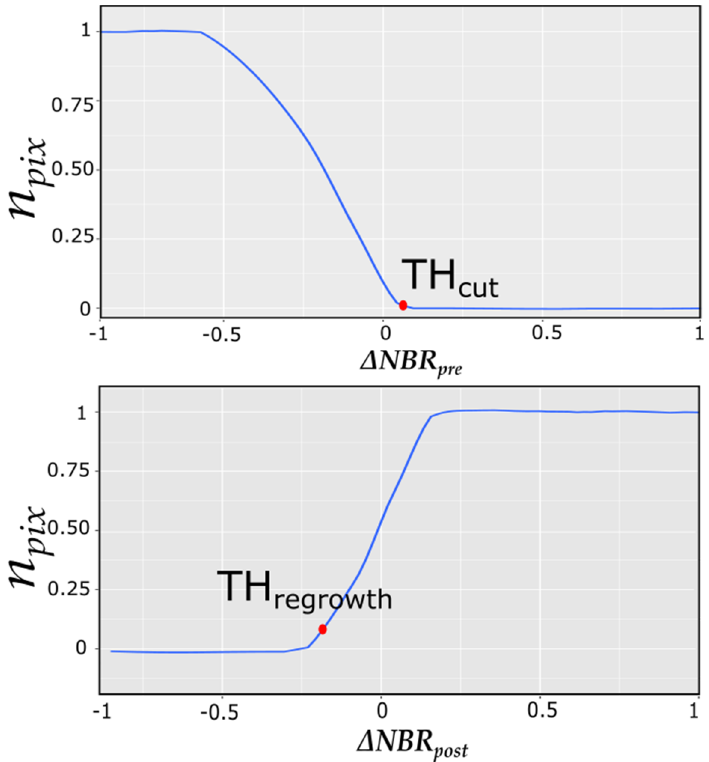
Figure 2. n pix threshold calculated by Two Thresholds Method (TTM) on the basis of cumulative